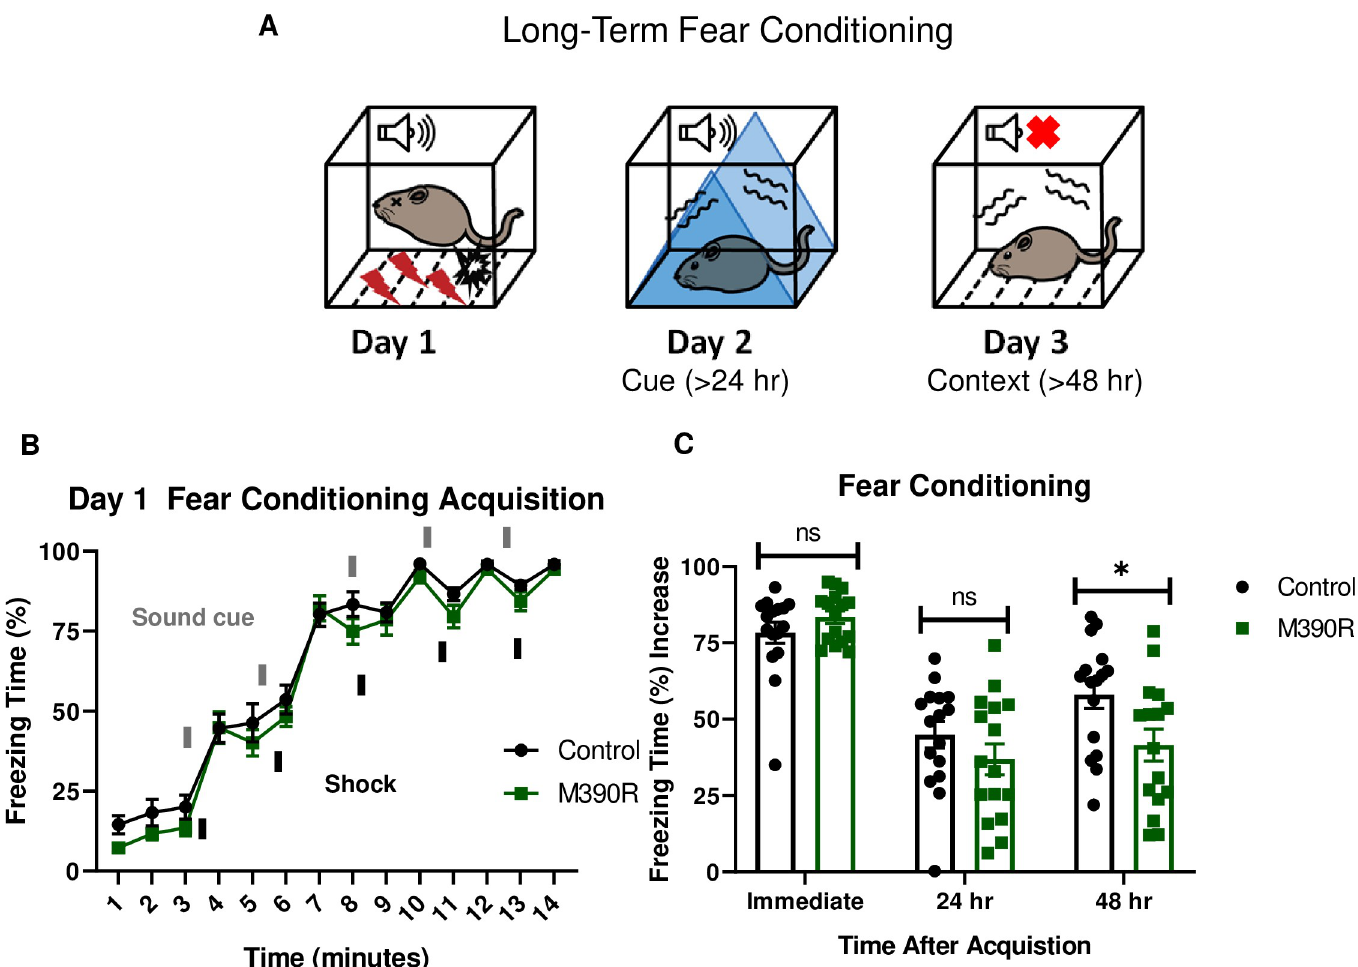
Fig 1. Bbs1 M390R/M390R mice have impaired long-term context fear conditioning. A.) Schematic diagram of the delay fear conditioning procedure. On the first day, a mouse is placed in a chamber, and a sound is paired with a shock multiple times. On the second day, a mouse is placed in an altered chamber. The chamber is triangle shaped (represented by the blue triangle) with a smooth floor, and a sound is given to test long-term cue fear conditioning. On the third day, the mouse is placed back in the same chamber (context) as day 1, without a sound cue. This set up is used to test long-term context fear conditioning. B.) Day 1 acquisition between the control mice (n = 16) and the Bbs1 M390R/M390R mice (n = 16) for long-term fear conditioning differed significantly (2-way ANOVA, time X genotype, F (13, 420) = 0.4488, P = 0.950, time, F (13, 420) = 179.8, P < 0.0001, genotype, F (1, 420) = 11.46, P = 0.0008). The thick lines above the curve indicate when the sound cue was given, and the thick lines below the curve indicate when the shock was given. C.) The immediate fear conditioning indicates training to the day 1 fear conditioning. The immediate fear conditioning is measured as the difference of the freezing time (%) just before conditioning (first three minutes) and just after conditioning (last minute). The immediate fear conditioning did not differ significantly between the control mice (n = 16) and Bbs1 M390/M390R mice (n = 16) used for long-term fear conditioning (Welch’s t-test, P = 0.2107). The post 24 hr fear conditioning represents cue fear conditioning, and is portrayed as Day 2 on the schematic diagram. The 24 hr fear conditioning (cue) is measured as the difference of the freezing time (%) before the tone (cue) on day 2 and during the tone (cue) on day 2. The 24 hr fear conditioning (cue) did not differ significantly between the control mice (n = 16) and the Bbs1 M390R/M390R mice (n = 16) (Welch’s t-test, P = 0.2414). The post 48 hr fear conditioning represents context fear conditioning, and is portrayed as Day 3 on the schematic diagram. The 48 hr fear conditioning is measured as the difference of the freezing time (%) just before conditioning (first three minutes of day 1) and during the context on day 3. The 48 hr fear conditioning (context) between the control mice (n = 16) and the Bbs1 M390R/ M390R mice (n = 16) differed significantly (Welch’s t-test, P = 0.0240). control mice = Bbs1 M390R/+ mice, M390R = Bbs1 M390R/M390R mice, hr = hour, ns = not significant, � P <